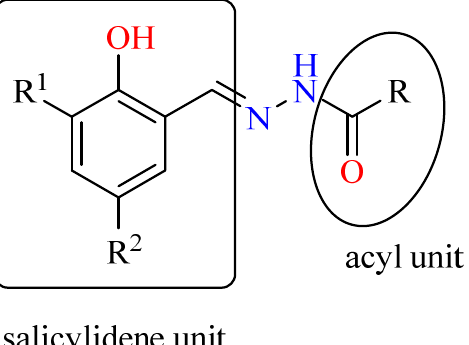
Figure 2. The general structure of investigated hydrazide-hydrazones. The fragment derived from salicylic aldehydes is a salicylidene unit, and the acyl unit originated from acid hydrazides.